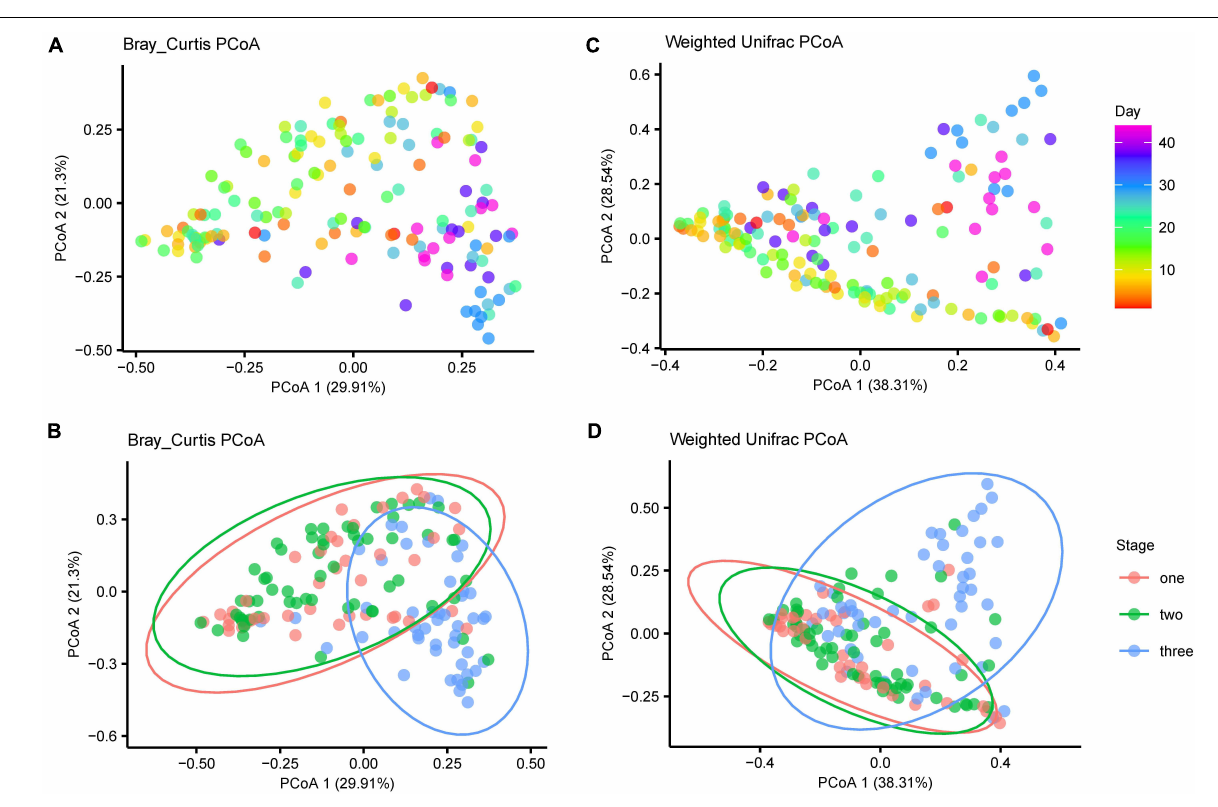
FIGURE 5 | The gut microbiota shift over time. Principle coordinate analysis showing that the gut microbiota with age since birth and stages. (A) Bray-Curtis distance for gut microbiota of the age effect (B) Bray-Curtis distance for gut microbiota of the three stages (C) weighted unifrac distances for gut microbiota of the age effect (D) weighted unifrac distances for gut microbiota of the three